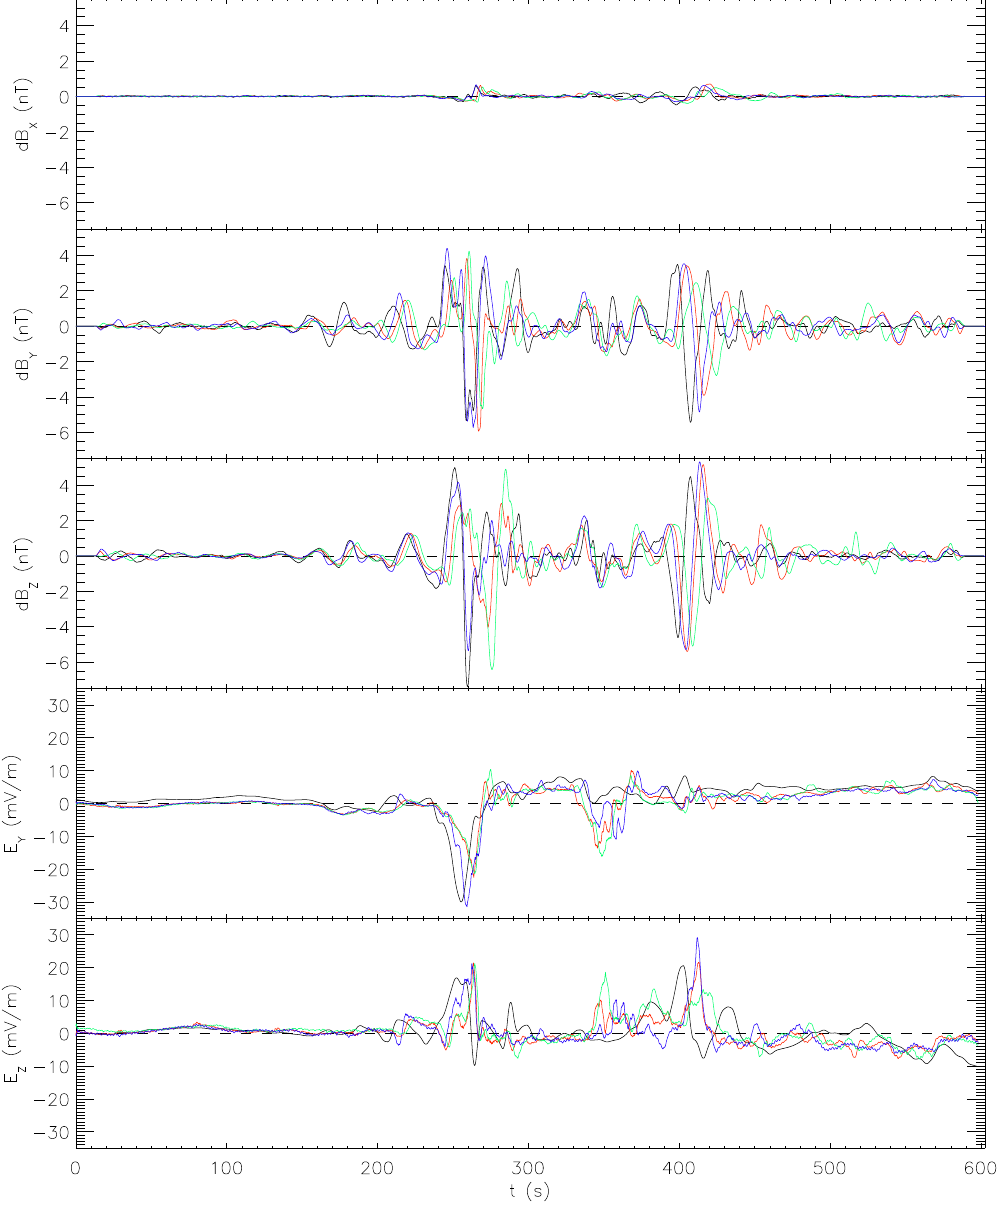
Fig. 2. Three components of the residual magnetic field d B and two components of the electric field E between 05:26 UT and 05:36 UT on 19 May 2002. The x-direction is anti-parallel to the ambient magnetic field, y and z are approximately to the geomagnetic west and north, respectively. E x is identically zero due to the assumption that E · B = 0. In all panels data from all the four Cluster satellites are shown, with the following colour coding: Cluster 1 – black, Cluster 2 – red, Cluster 3 – green, Cluster 4 –